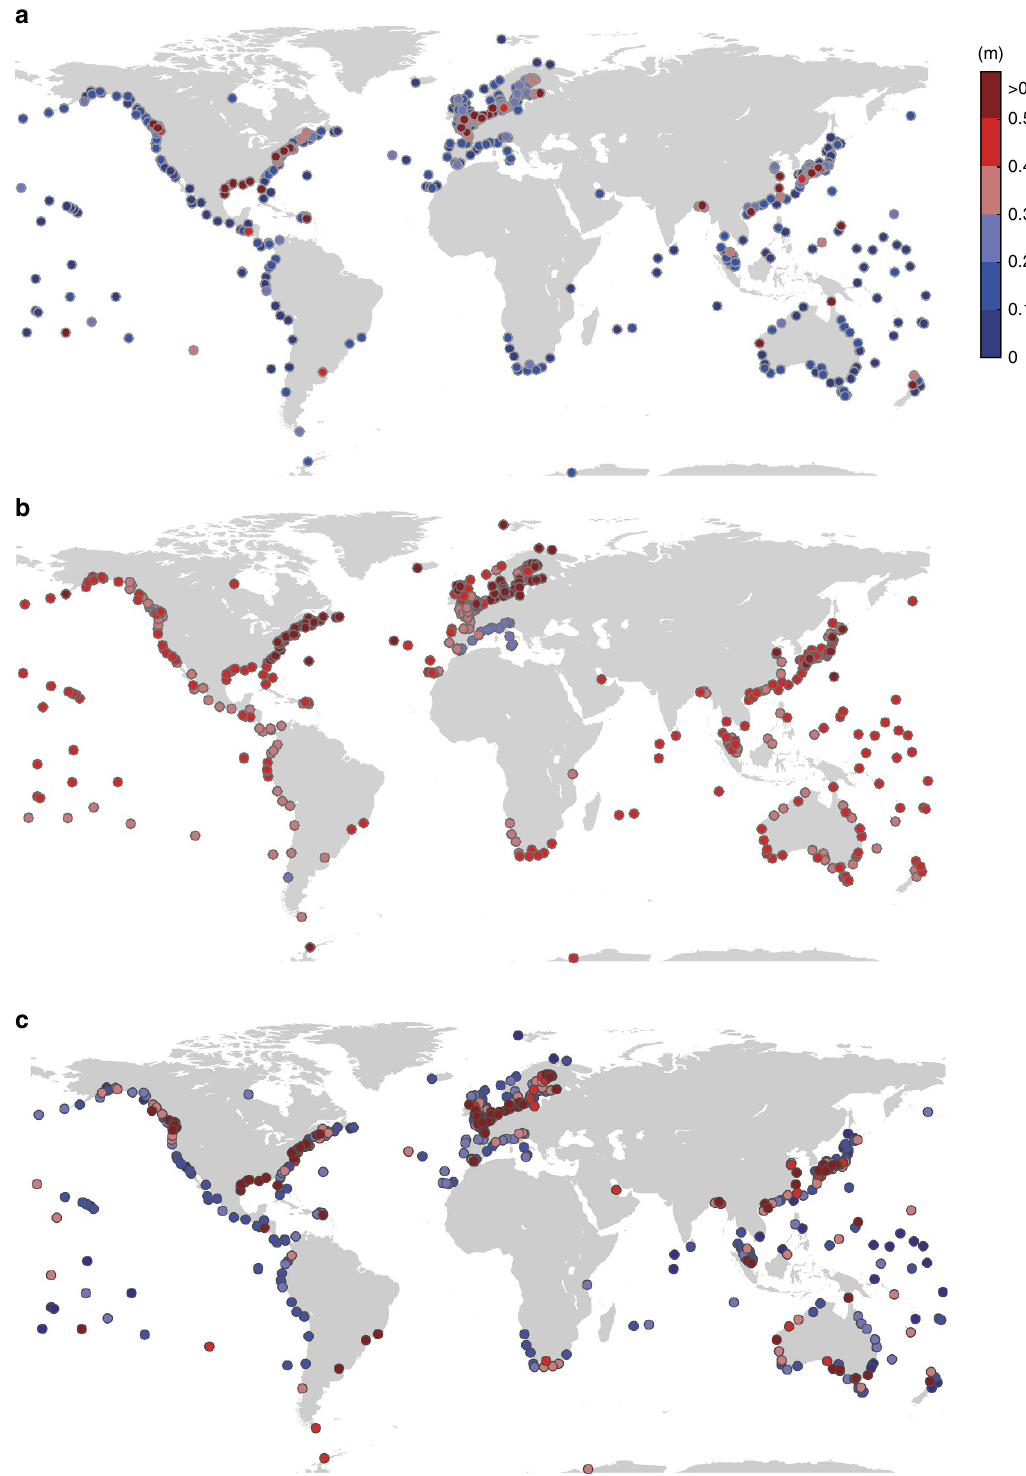
Figure 2 | Uncertainties in present-day extreme sea level estimates and in regional sea-level rise projections. ( a ) 5 to 95% inter-model uncertainty ranges in 100-year return water levels. ( b ) 5–95% uncertainty ranges in regional sea- level rise projections under the Representative Concentration Pathway 4.5 scenario (2081–2100 mean minus 1986–2005 mean) at grid points closest to the tide gauge locations. ( c ) Combined extreme sea level uncertainties (100-year events) from summing up the 5–95% inter-model uncertainties from the extreme value analysis and (absolute) offsets found in the Global Tide and Surge Reanalysis (GTSR) model data